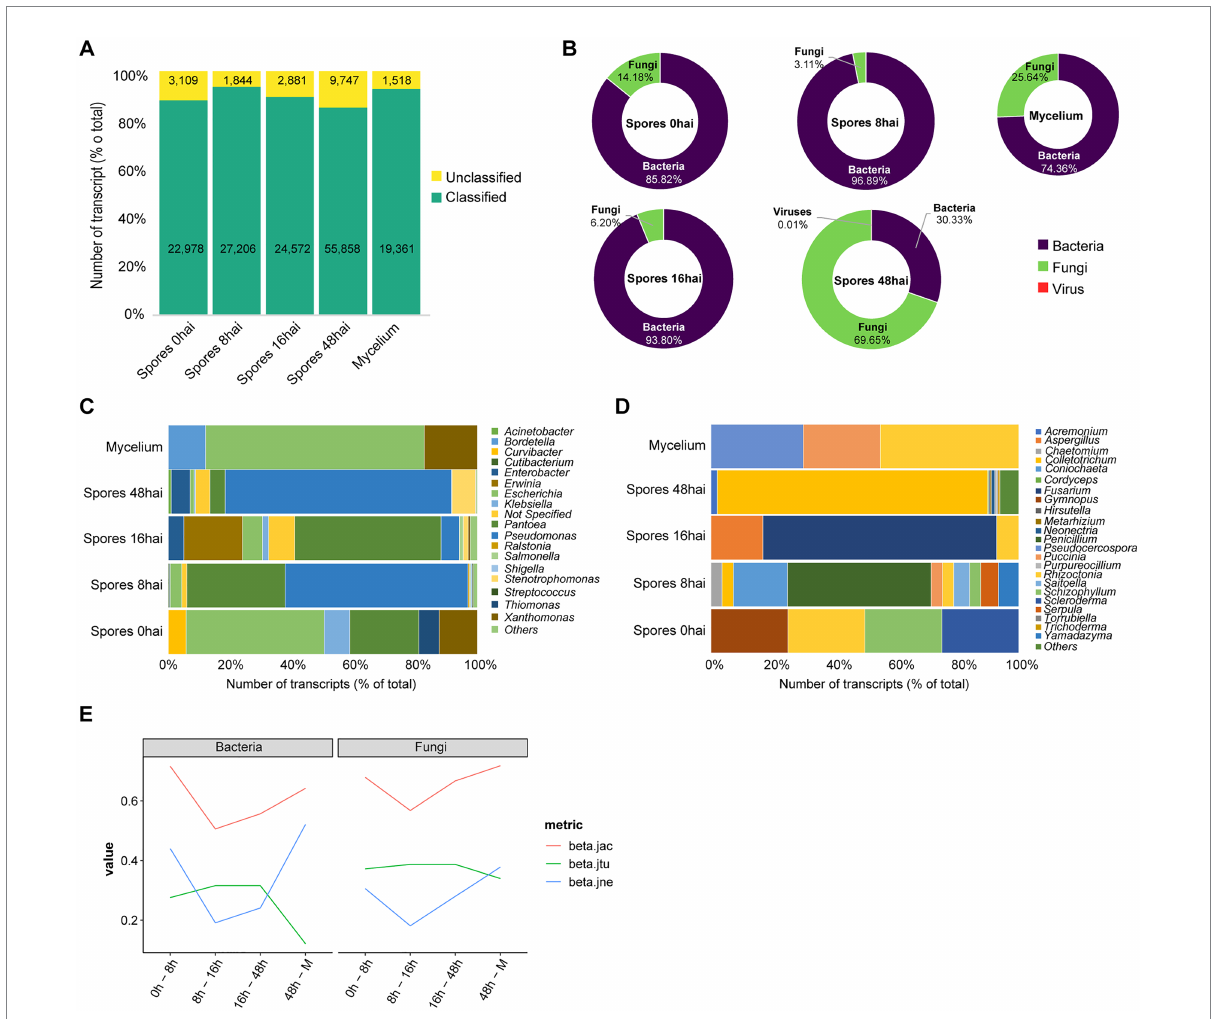
FIGURE 1 Metagenomics analysis of Theobroma cacao pods infected by Moniliophthora roreri . (A) Overview of taxonomic assignment of assembled transcripts by condition. (B) Abundance of fungi, bacteria and virus in the samples. Diversity of bacteria (C) and fungi (D) by genera. (E) Temporal changes in microbiota of T. cacao fruits along M. roreri infection time points. beta.jtu, beta.jne and beta.jac, represents the partitioning of beta diversity into turnover, nestedness and jackniffe, respectively. hai: hours after